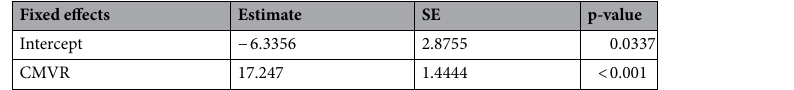
Table 3. Estimated results and regression coefficients regarding CMVR in LMM. CMVR change in the magnitude of the vibration response, LMM linear mixed effects model.